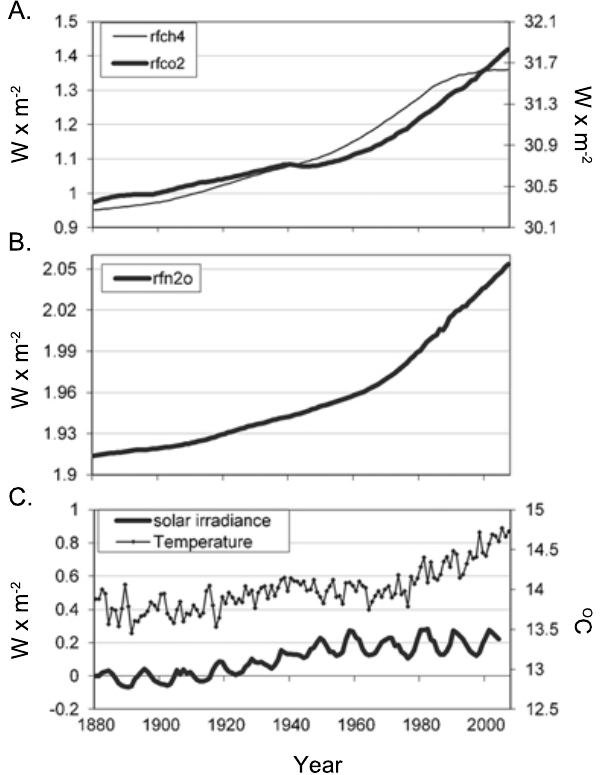
Fig. 1. Time series of the changes that occurred in several variables that affect or represent climate changes during the 20th century. (a) Radiative forcings (rf, in units of Wm − 2 ) during 1880 to 2007 of CH 4 (methane) and CO 2 (carbon dioxide); (b) same period as in panel a but for Nitrous-Oxide (N 2 O); (c) solar irradiance (left ordinate, units of Wm − 2 ) and annual global temperature (right or- dinate, units of ◦ C) during 1880–2003.